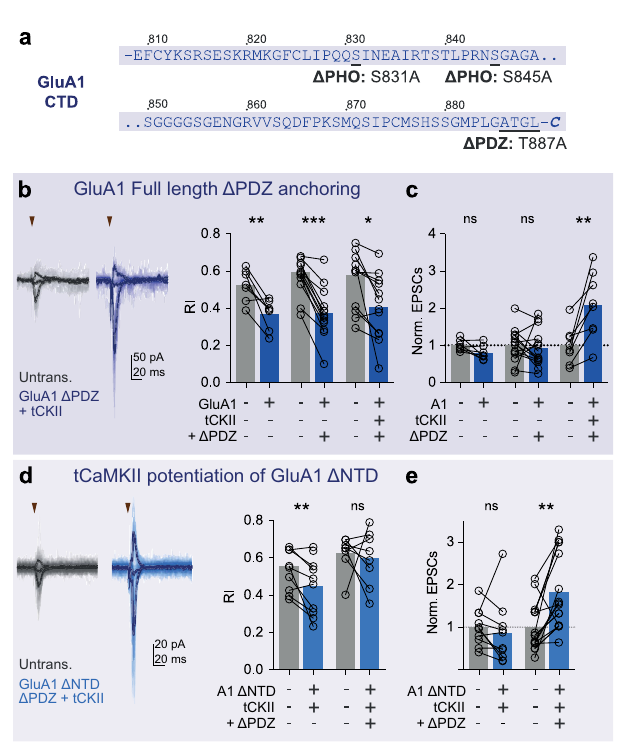
Fig. 2 GluA1 CTD interactions exert a modulatory but nonessential in fl uence on receptor synaptic anchoring. a GluA1 CTD protein sequences with interaction mutations indicated. Dual recording of RI b and AMPAR EPSCs c from transfected and untransfected (Untrans.) cells demonstrates that PDZ-ligand mutation does not prevent full-length GluA1 synaptic anchoring in basal conditions, or in tCaMKII (tCKII)-dependent potentiation. d – e tCaMKII (tCKII) potentiation of synaptic responses is prevented by GluA1 Δ NTD, but not by GluA1 Δ NTD with a mutated PDZ- ligand ( d - Dual cell Recti fi cation Index, e Normalised AMPAR EPSC amplitudes). Prenormalised data are depicted in Supplementary Figure 3b, and data values and statistical details are presented in Supplementary Table 2. Bars represent mean values, * indicates p < 0.05, ** p < 0.01, *** p < 0.001 and ns speci fi es no signi fi cance. Source data are provided as a source data fi